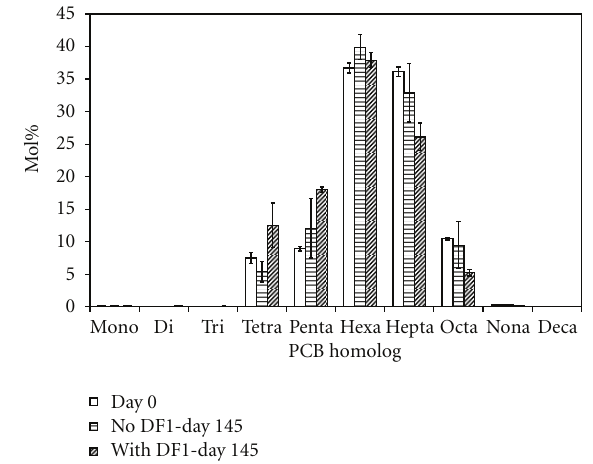
Figure 3: Homolog distribution showing the e ff ect of DF-1 in the bioaugmentation experiment compared to e ff ect of the indigenous population for